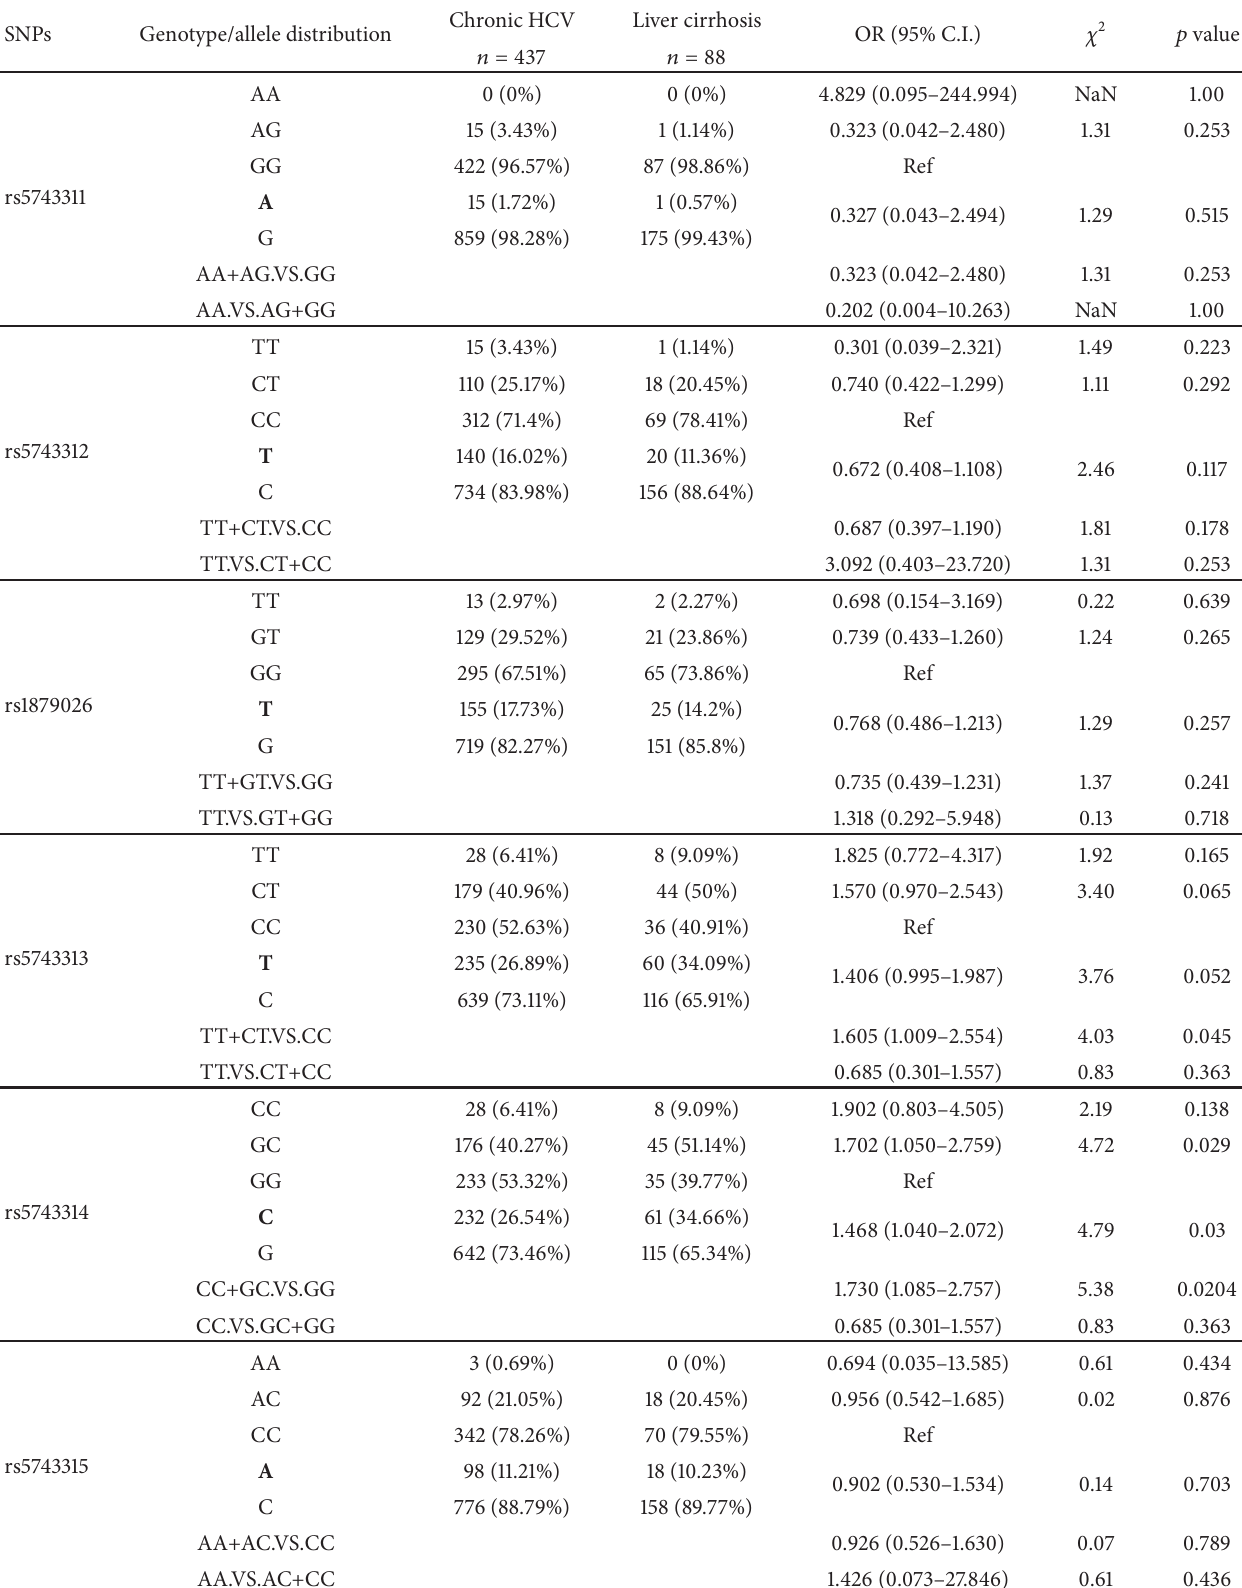
Table 4: Genotypic distribution of TLR3 gene polymorphisms when chronic HCV patients were compared to patients diagnosed with liver